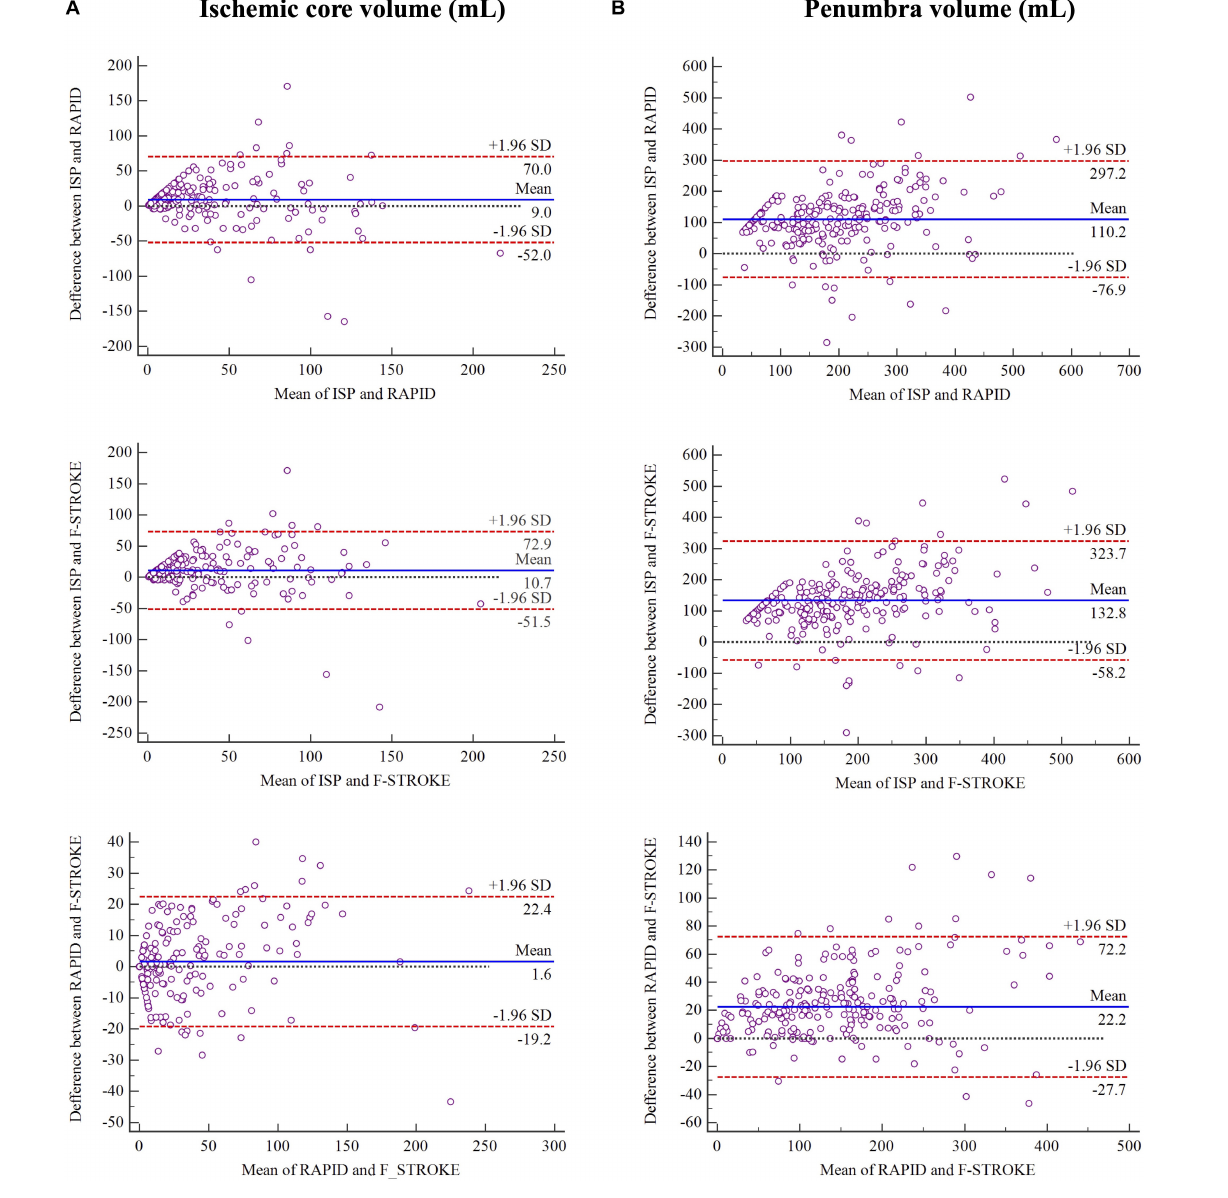
FIGURE 2 | Bland-Altman plots for the agreement and bias in measuring ischemic core volume in panel (A) and penumbra volume in panel (B) between any two software